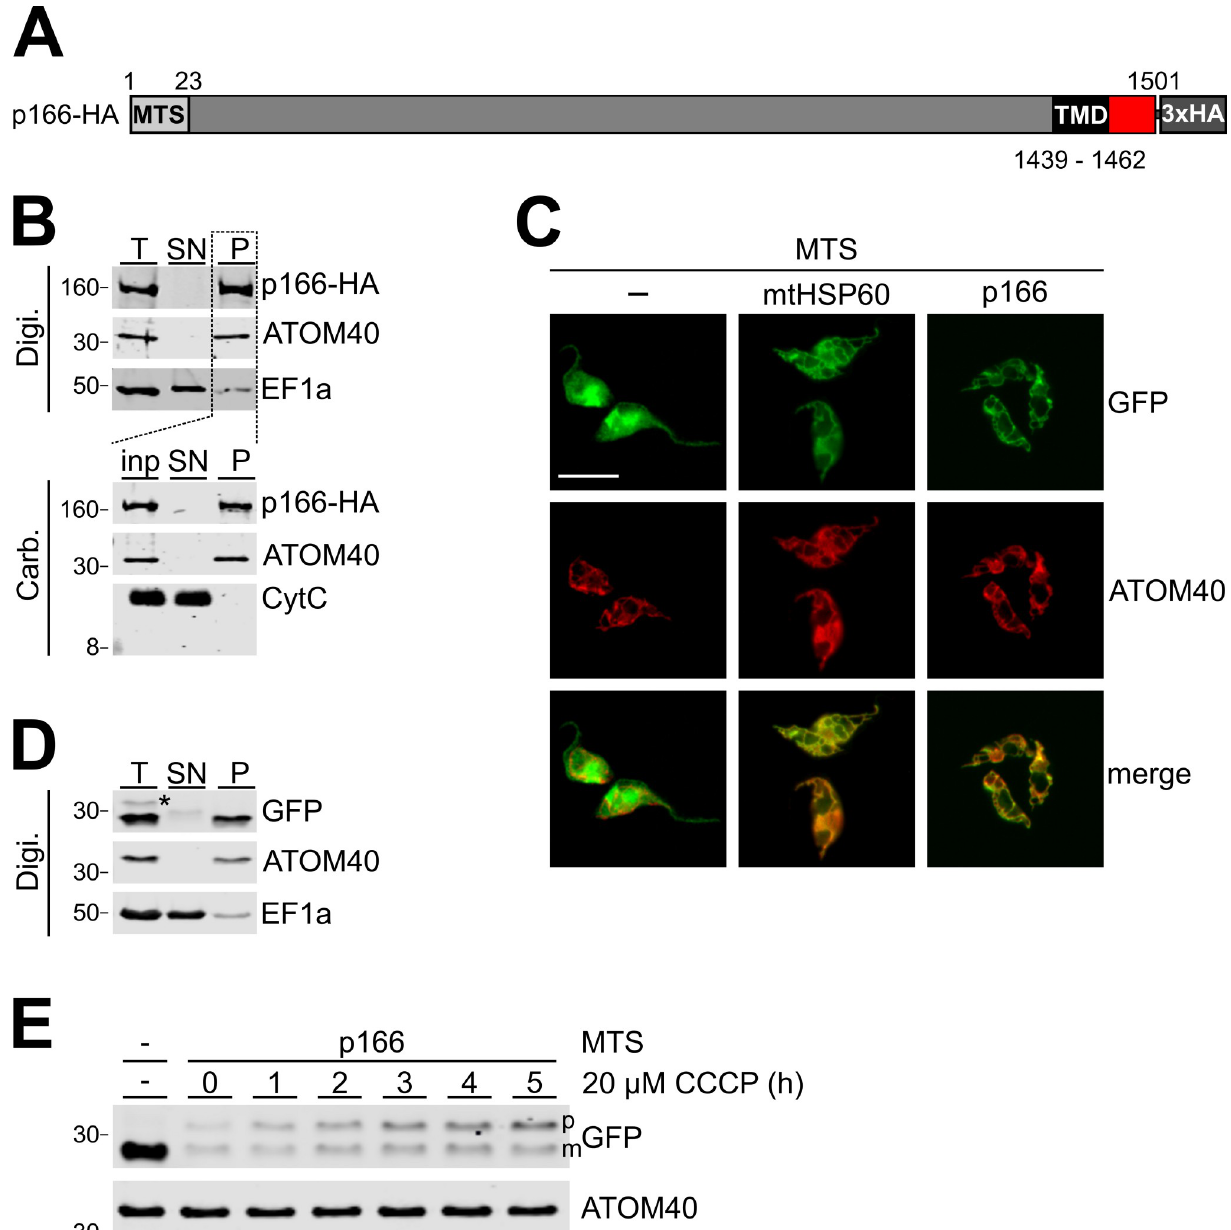
Fig 2. p166-HA is an integral membrane protein of the IM. (A) Schematic depiction (not to scale) of in situ tagged p166. A predicted mitochondrial targeting sequence (MTS) and transmembrane domain (TMD) are indicated. Numbers represent the position of amino acid residues. (B) Biochemical fractionation of cell extracts. For digitonin (Digi.) extraction same cell equivalents of total cells (T), supernatant (SN) and pellet (P) were separated by SDS-PAGE and p166-HA, the mitochondrial outer membrane protein ATOM40 and the cytoplasmic marker EF1a were detected by immunoblot. The pellet served further as input (inp.) for alkaline carbonate (Carb.) extraction and was separated into supernatant and a final pellet. On immunoblots p166-HA, ATOM40 and the soluble protein cytochrome C (CytC) were detected. Numbers on the left indicate sizes of molecular weight marker bands in kDa. (C) Fluorescence microscopy analysis of tetracycline inducible cells expressing variants of GFP with indicated mitochondrial targeting sequences (MTS) fused to the N-terminus. Staining for ATOM40 serves as marker for mitochondria. (D) Digitonin extraction as in (B) of the cell line expressing GFP with the p166 MTS. Asterisk indicates the putative unprocessed precursor protein. (E) The cell line expressing GFP with the p166 MTS was induced for 2 hours and subsequently treated with the uncoupler CCCP as indicated. Subsequently total cellular extract was analyzed by SDS-PAGE. Left most lane shows GFP alone. Position of precursor p166-MTS-GFP (p) and mature GFP are indicated (m). ATOM40 serves as a loading control.